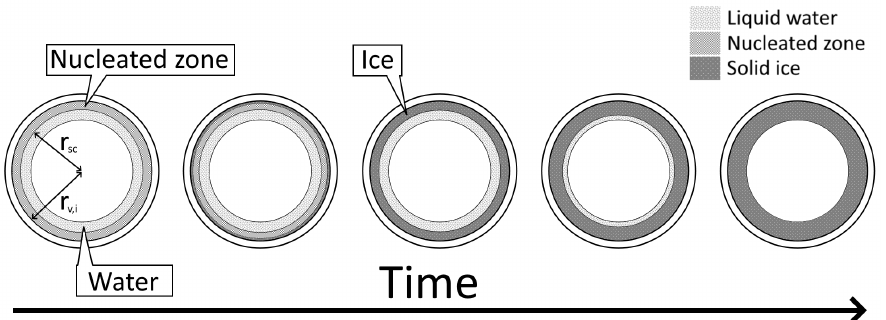
Figure 4. Axial view of spin freezing with ice layer thickness progression from left to right. The ice layer grows over time as more water crystallizes into ice, until all water has solidified and the crystal growth phase is complete. The inner vial radius r v , i and the radius of the nucleated zone r sc are